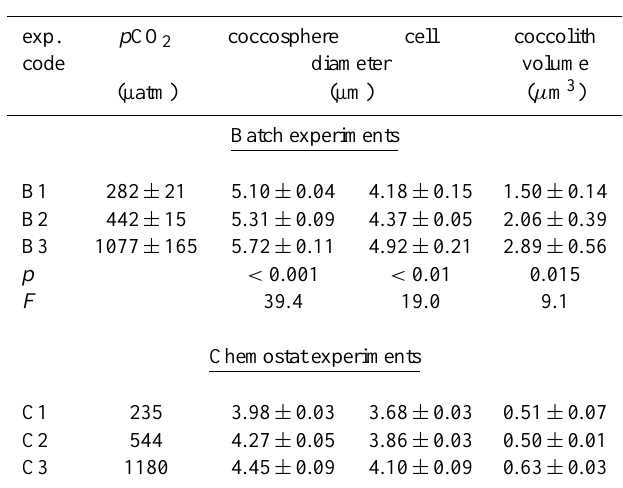
Table 4. Coccosphere/cell diameter and coccolith volume from the batch and chemostat experiments. Significance was tested for the batch culture experiments (1SD, n = 3) using a one-way ANOVA ( p < 0 . 05). Standard deviation for the chemostat experiments were derived from 10 repeated measurements during the equilibrium state (one sampling per day over the course of 10 days).